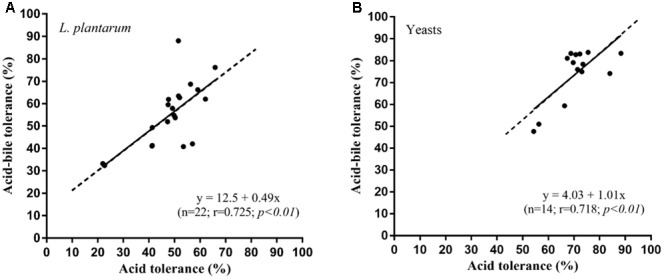
Relationship between acid-tolerance and combined acid-bile tolerance in L. plantarum
(A) and yeast (B) strains.